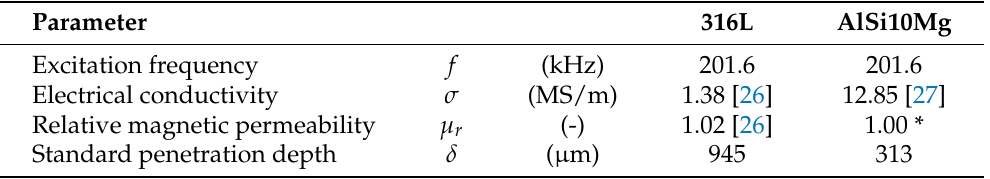
Table 2. Calculated standard penetration depths for 316L and AlSi10Mg. * assumed because Aluminum alloys are paramagnetic [26].